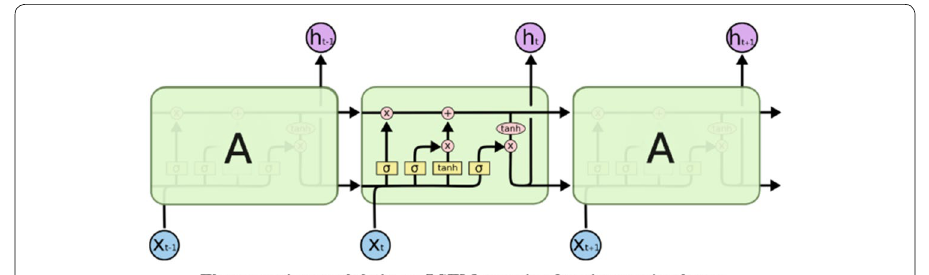
Fig. 3 LSTM architecture [39]. Shows in details architecture of long short term memory